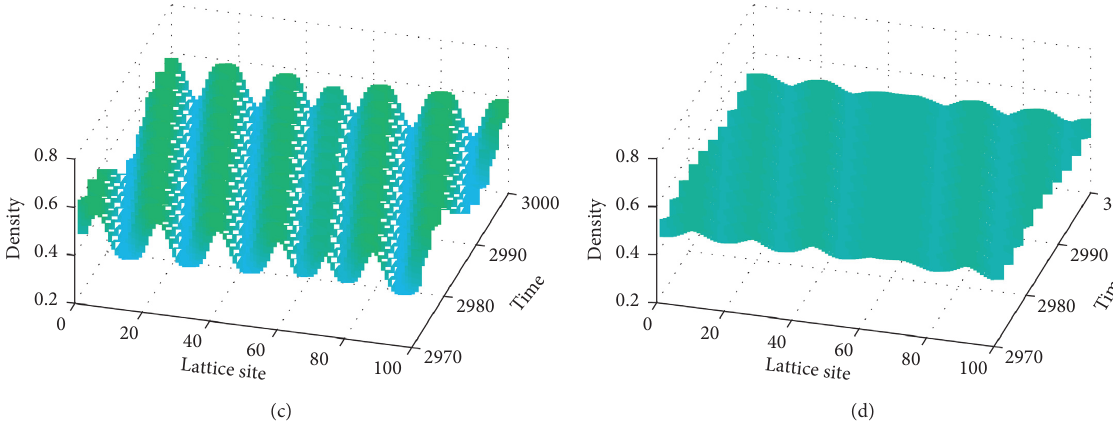
Figure 7: The phase diagram of the model according to different values of parameter c . (a) c � 0, (b) c � 0.1, (c) c � 0.2, (d) c � 0.3. 0.30.40.50.60.7